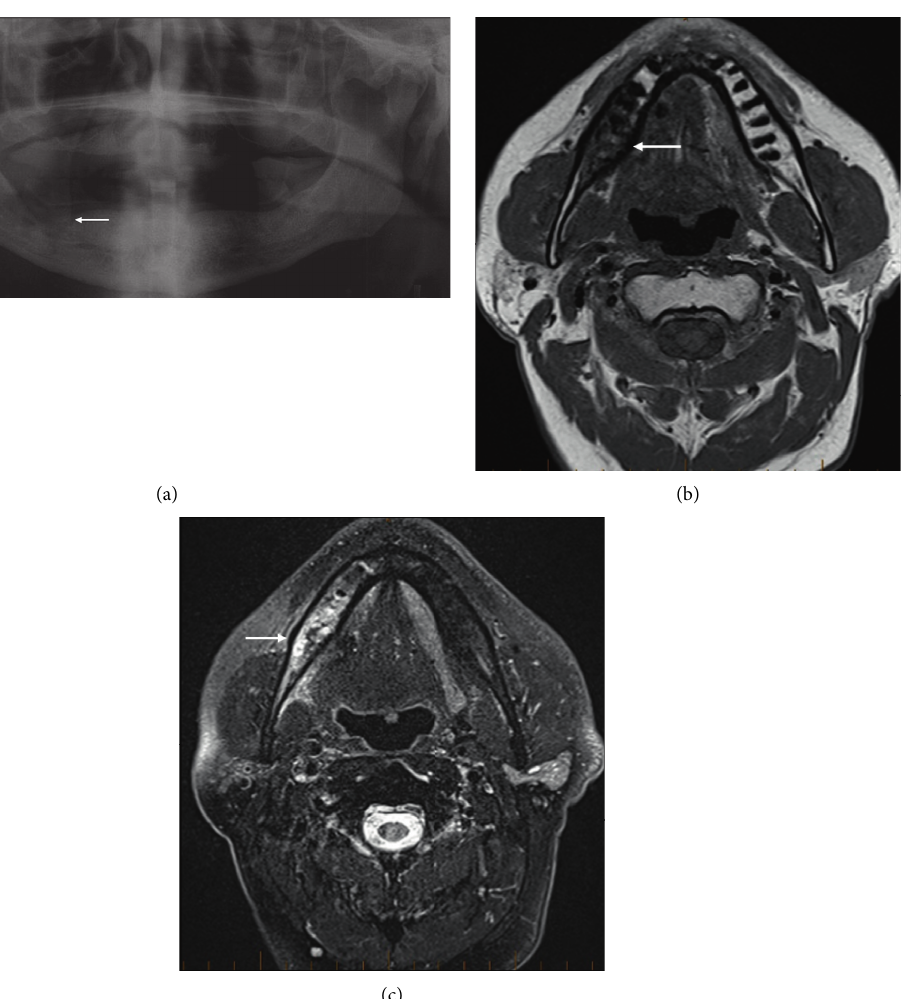
Figure 17: Osteoradionecrosis. Orthopantomogram (OPG, (a)) of a 74-year-old male with a history of T3 oropharyngeal tumour having undergone prior resection and chemoradiotherapy, complicated by osteoradionecrosis. There is ill-defined lytic lucency eroding the right mandibular body with background coarsened trabeculation and patchy sclerosis. Axial T1 (b) and T2FS (c) of a different patient with a previous history of radiotherapy for skin SCC, presenting with a nonhealing ulcer due to osteoradionecrosis. There are T1 hypointensity and fluid-hyperintensity in the body of the right mandible ((a) arrow). Mild surrounding soft tissue oedema ((b) arrow).